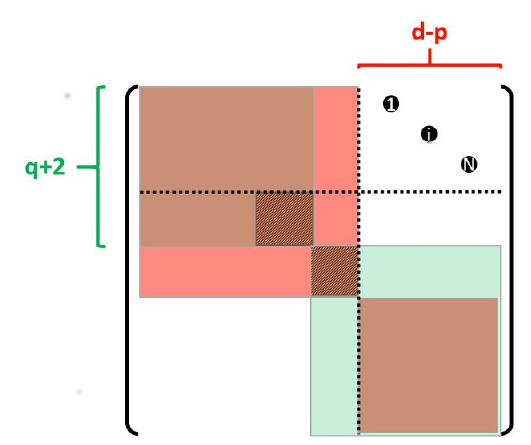
Figure 2 . The (cid:12)gure illustrates our choice of coordinates on the conformal group. The blocks in red/green correspond to the left/right group G p =G q while the additional generators M i (cid:0) 1 ;p +1+ i are represented by block dots. The subgroup B pq of elements that commute with M i (cid:0) 1 ;p +1+ i ; i = 1 ; : : : ; N is shown as the shaded area. Obviously, it is contained in the intersection of G p and G q (brown